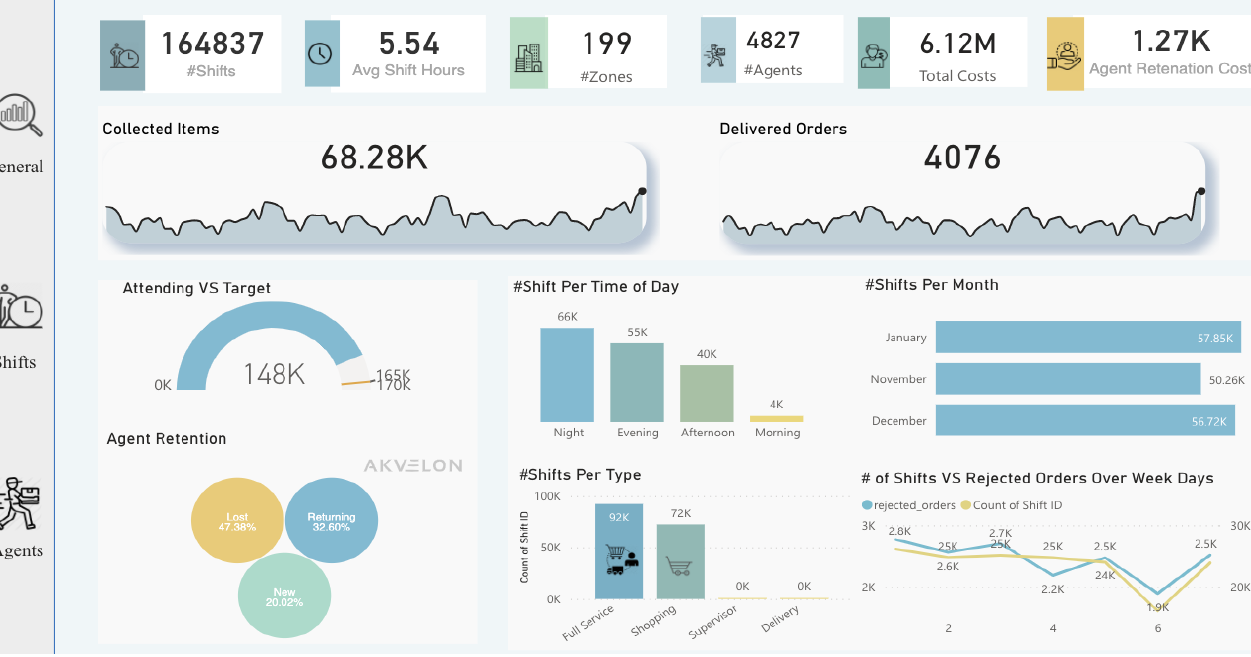
Figure 11. Dashboard (general tab) designed after analysis.